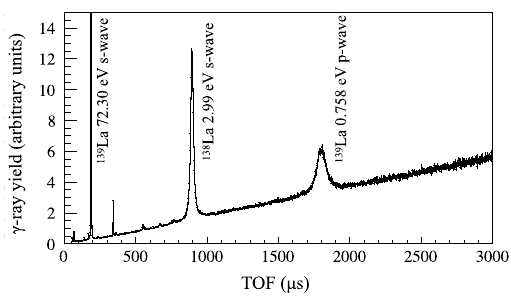
Figure 6. γ -ray yield as function of neutron time of flight measured with the La